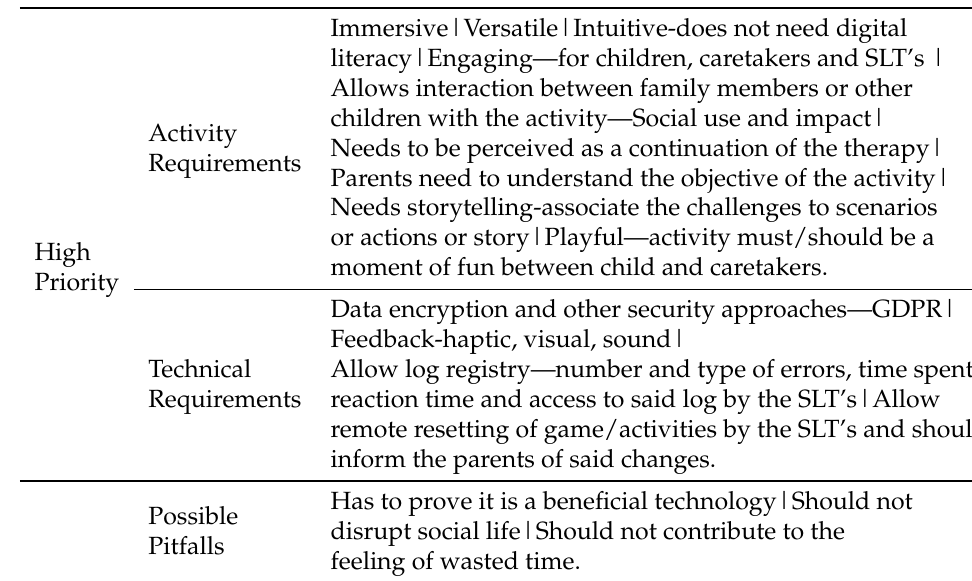
Table 1. High priority requirements as well as identified